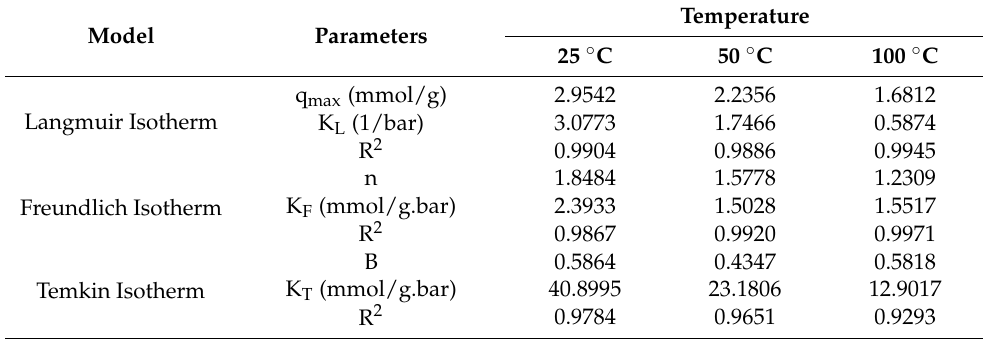
Table 4. Fitted parameters of three isotherm models for CO 2 adsorption on RSS-IL 800. Model